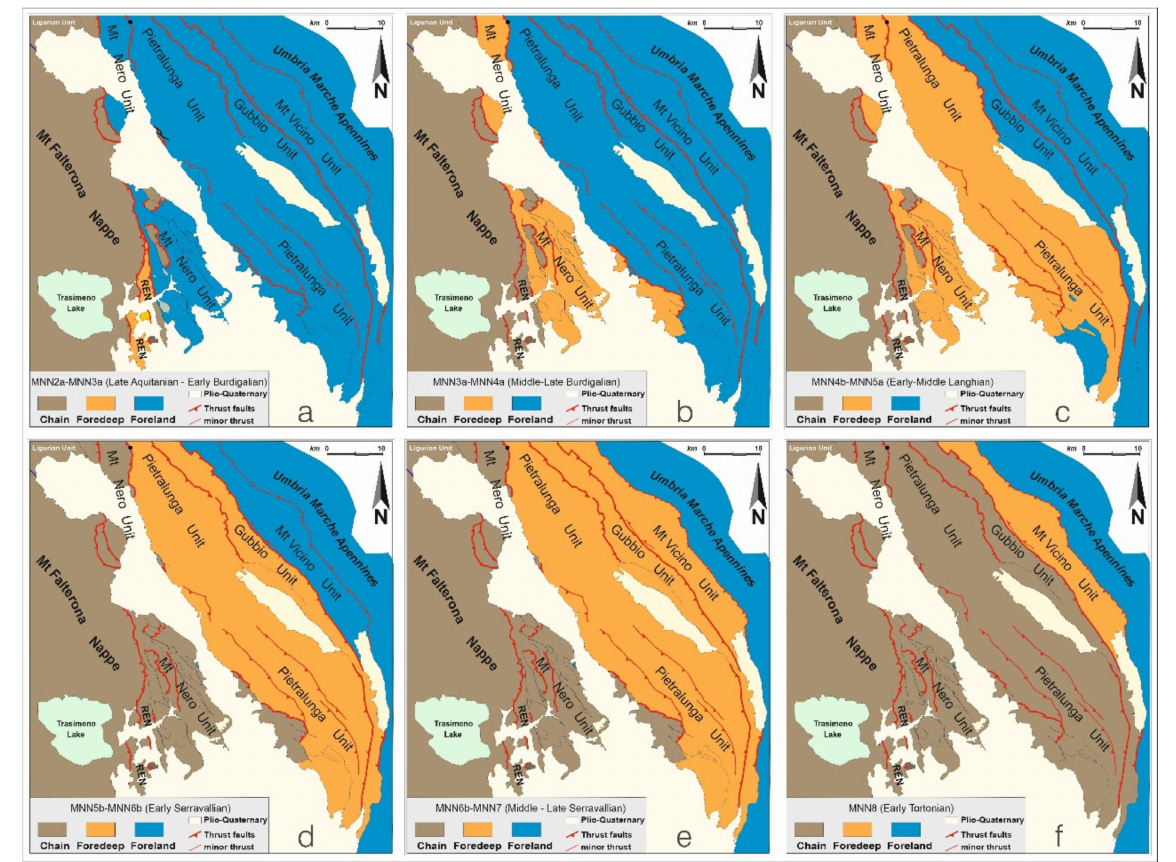
Figure 7. Distribution of the pre-Apennines structural paleo-domain, as inferred by the high-resolution tectono-stratigraphic timing summarized in Figure 6, during the: ( a ) Late Aquitanian-Early Burdigalian, ( b ) Middle-Late Burdigalian, ( c ) Early- Middle Langhian, ( d ) Early Serravallian, ( e ) Late Serravallian; ( f ) Early Tortonian. Note that the migrating paleo-domains are shown by the brown, orange, and blue colors and that the thrust faults refer to the present configuration, taken from Figure